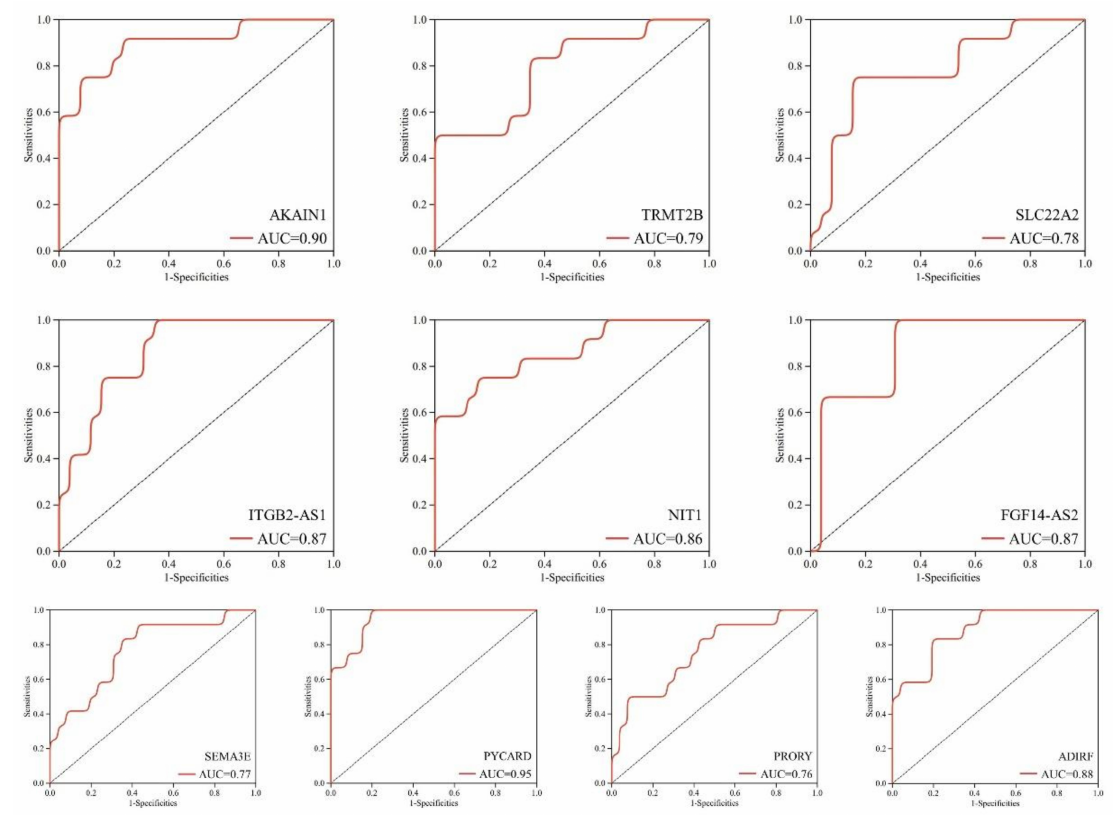
Figure 5. Diagnostic values of DEGs were evaluated by AUC curve in AD. AKAIN1 : AUC = 0.90; TRMT2B : AUC = 0.79; SLC22A2 : AUC = 0.78; ITGB2-AS1 : AUC = 0.87; NIT1 : AUC = 0.86; FGF14-AS2 : AUC = 0.87; SEMA3E : AUC = 0.77; PYCARD : AUC = 0.95; PRORY : AUC = 0.76; ADIRF : AUC = 0.88. The dotted line (diagonal line) indicates an invalid ROC curve, and an AUC value less than 0.5 indicates no diagnostic